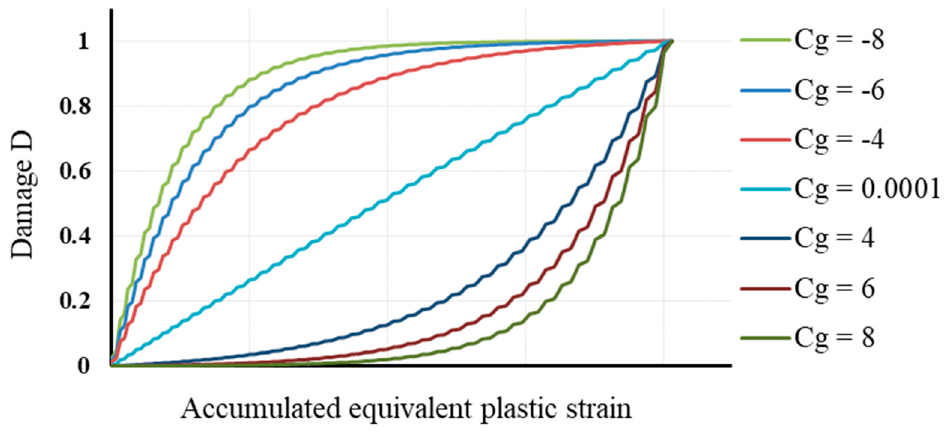
Figure 2. Schematic illustration showing ductile damage in metals. ( a ) Virgin material, ( b ) nucleation and growth of microscopic cracks and voids, ( c ) void coalescence and macroscopic fractures, and ( d ) a diagram presenting di ff erent stress states of stress triaxiality η and Lode angle θ . Reproduced from Reference [1,20], with permission from Elsevier, 2019.